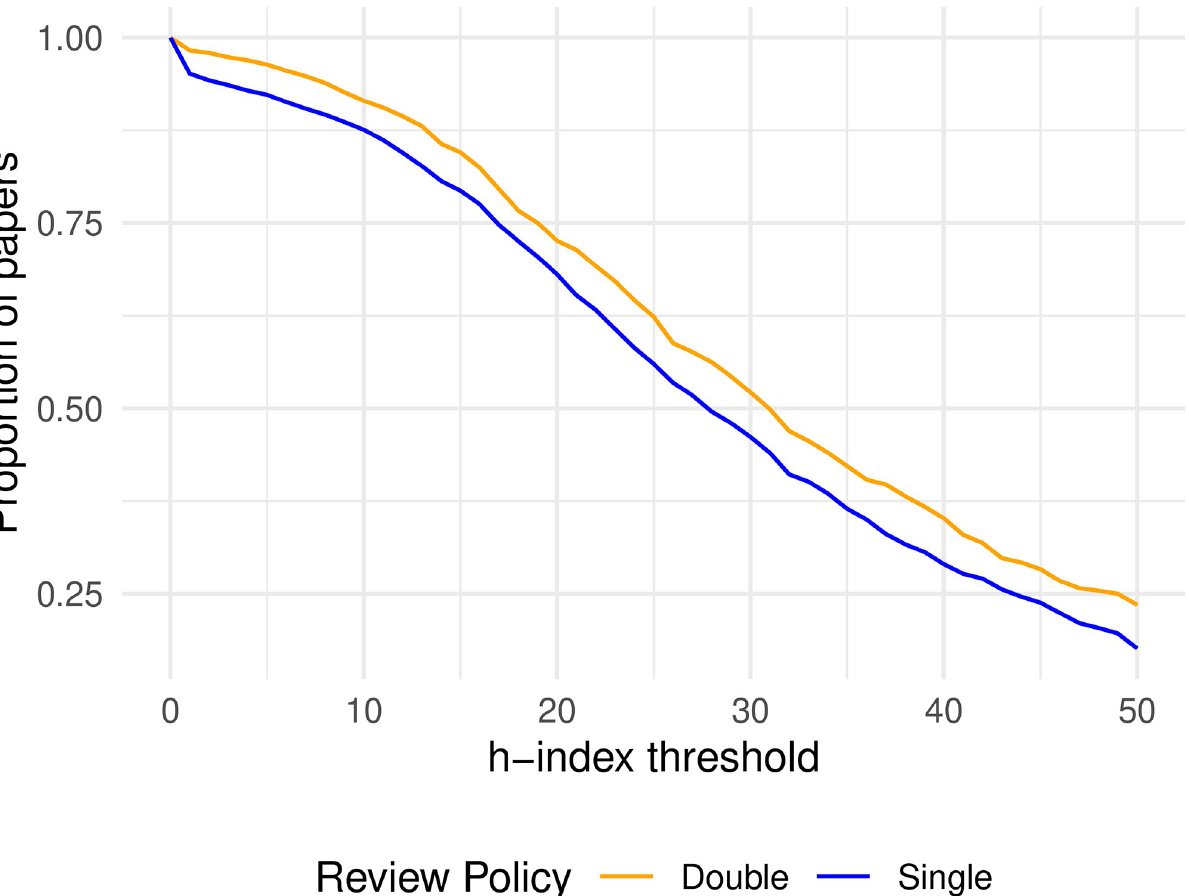
Fig 6. Proportion of papers that have at least one author with an h-index value above the